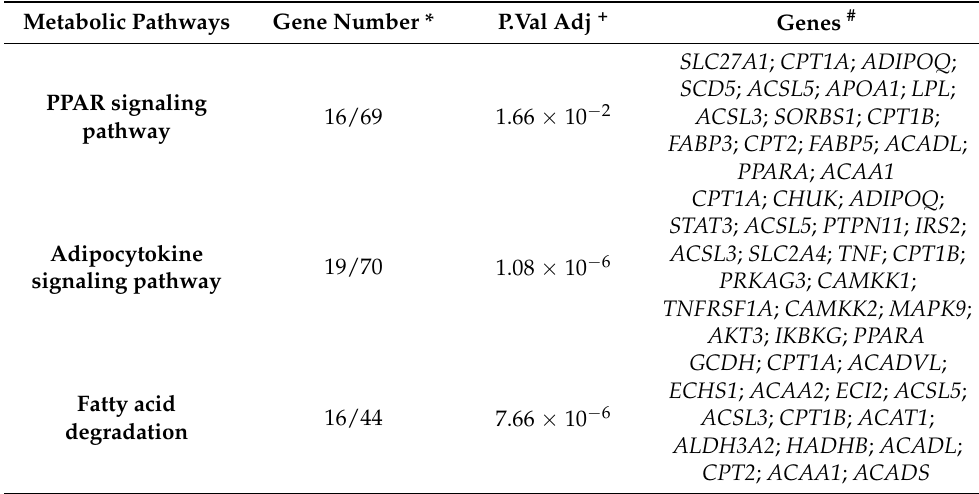
Table 2. Three most relevant metabolic pathways of the GO $ enrichment analysis associated with lipid